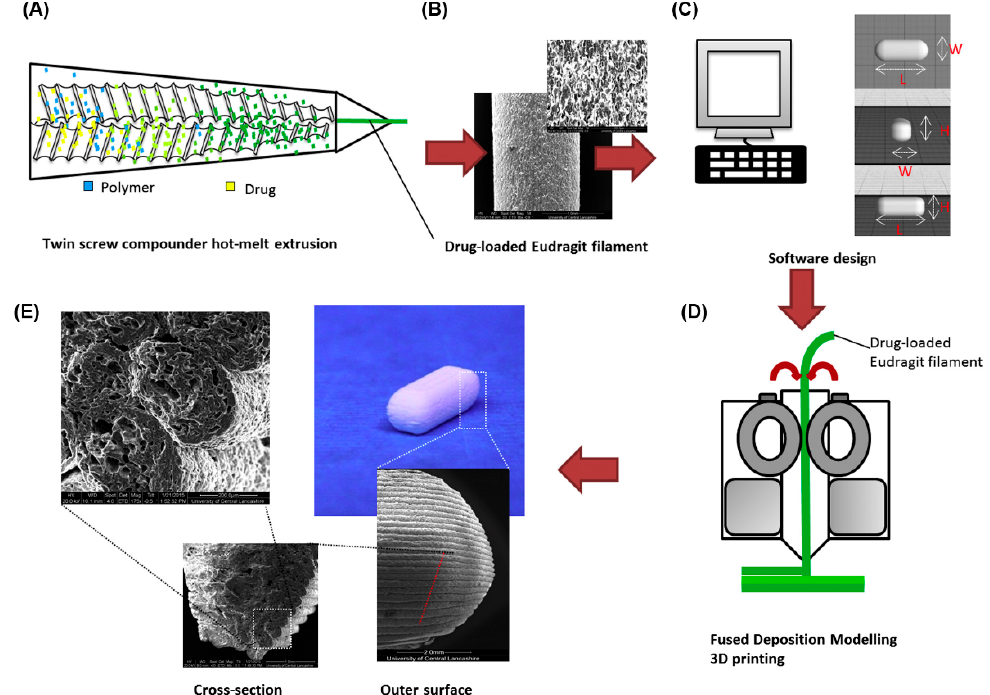
Figure 5. Fabrication of 3D-printed controlled-release theophylline tablet. ( A ) Schematic illustration of hot-melt extrusion to produce theophylline loaded filaments. ( B ) Drug-loaded filament. ( C ) Design of the capsule-shaped tablet. ( D ) Printing by fused deposition modelling. ( E ) 3D printed Eudragit tablets with a 200 μ m layer thickness as shown in scanning electron microscopy (SEM) images. Reprinted from [85], copyright 2015, with permission from Elsevier.